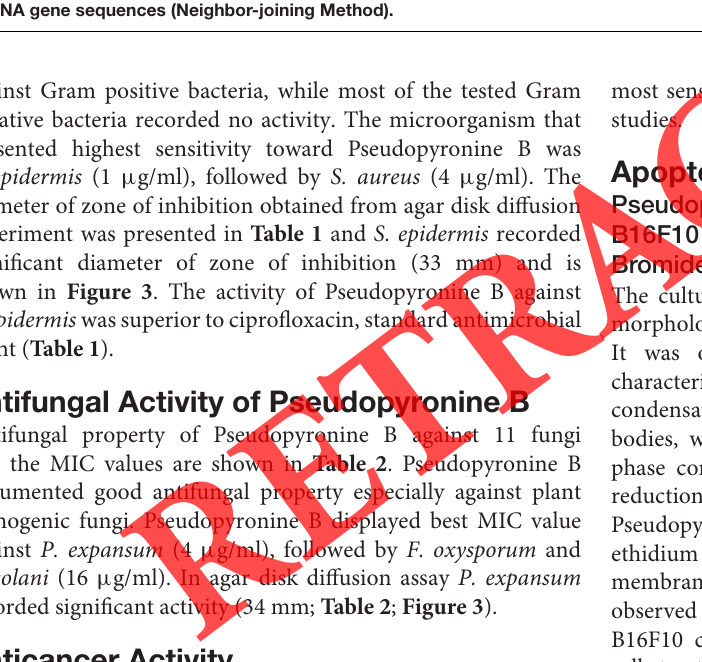
FIGURE 1 | Phylogenic tree displaying the relationships of Pseudomonas mosselii TR strain and other known Pseudomonas species based on 16S rDNA gene sequences (Neighbor-joining